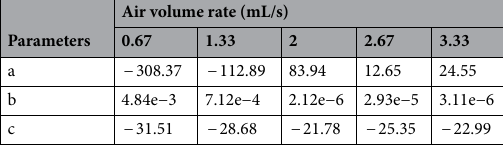
Air volume rate Parameters